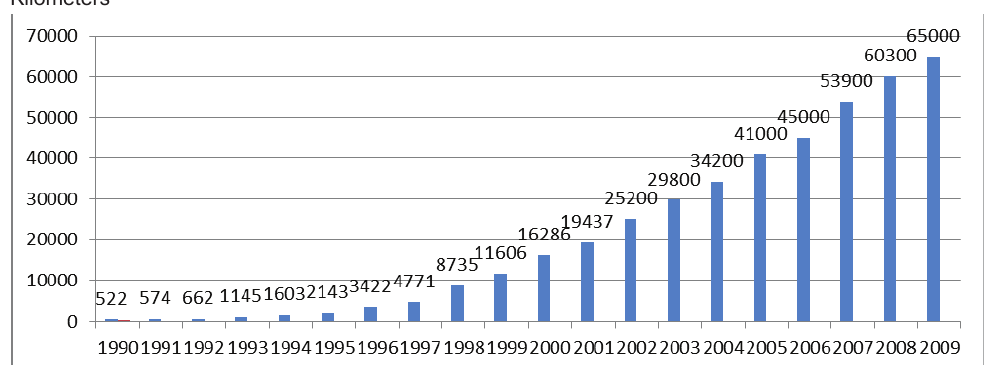
figure 1. Development history of highway system in China